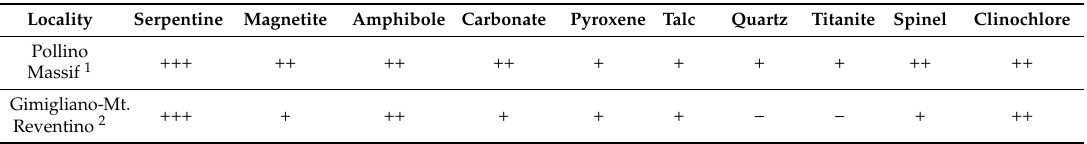
Table 2. Mineral assemblage of the studied serpentinites as detected by XRD, where (+ + +) = major phase, (++) = minor phase (<10%), (+) = trace phase, and ( − ) =